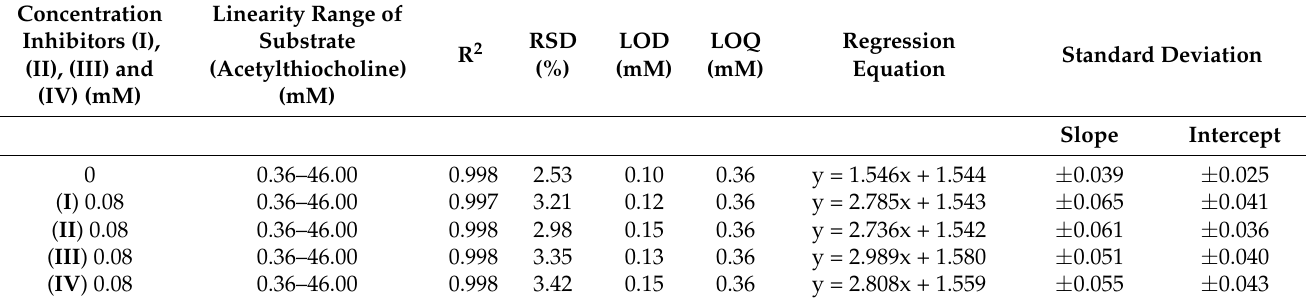
Table 1. Regression equation and quantification for acetylthiocholine for 6 replicates for each sample ( n = 6) in the concentration range 0.36–46.00 mM, in the presence of inhibitors ( I ), ( II ), ( III ) and ( IV ) at a concentration of 0.08 mM.